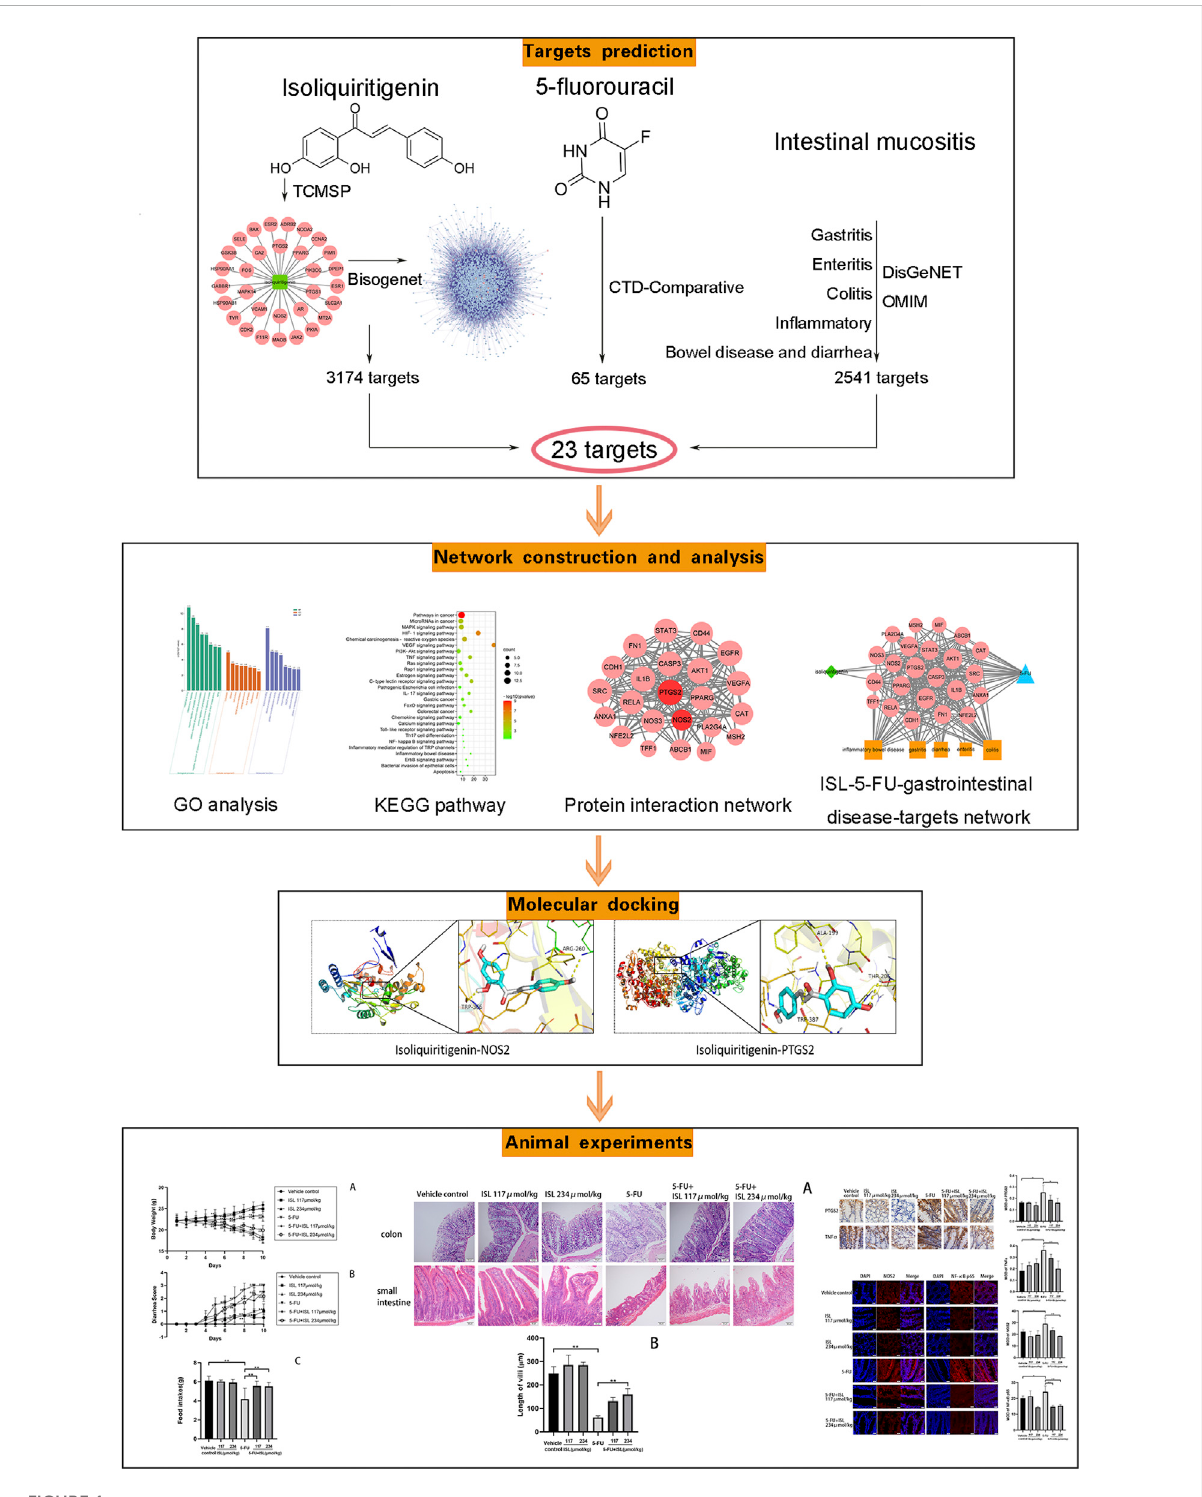
FIGURE 1 Flow chart of this